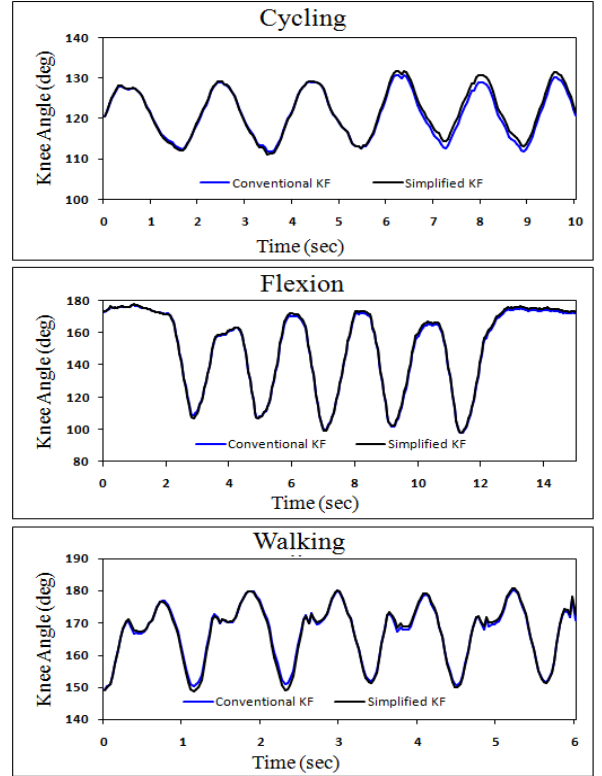
Figure 6 Knee angle profiles for cycling, flexion and